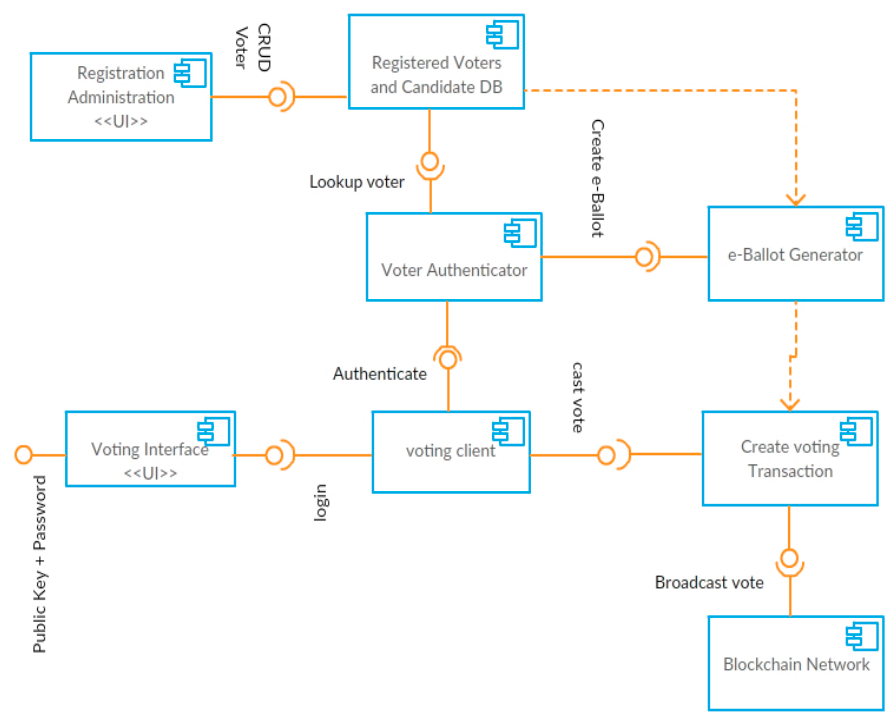
Figure 4. Development View—UML component diagram of BANES.